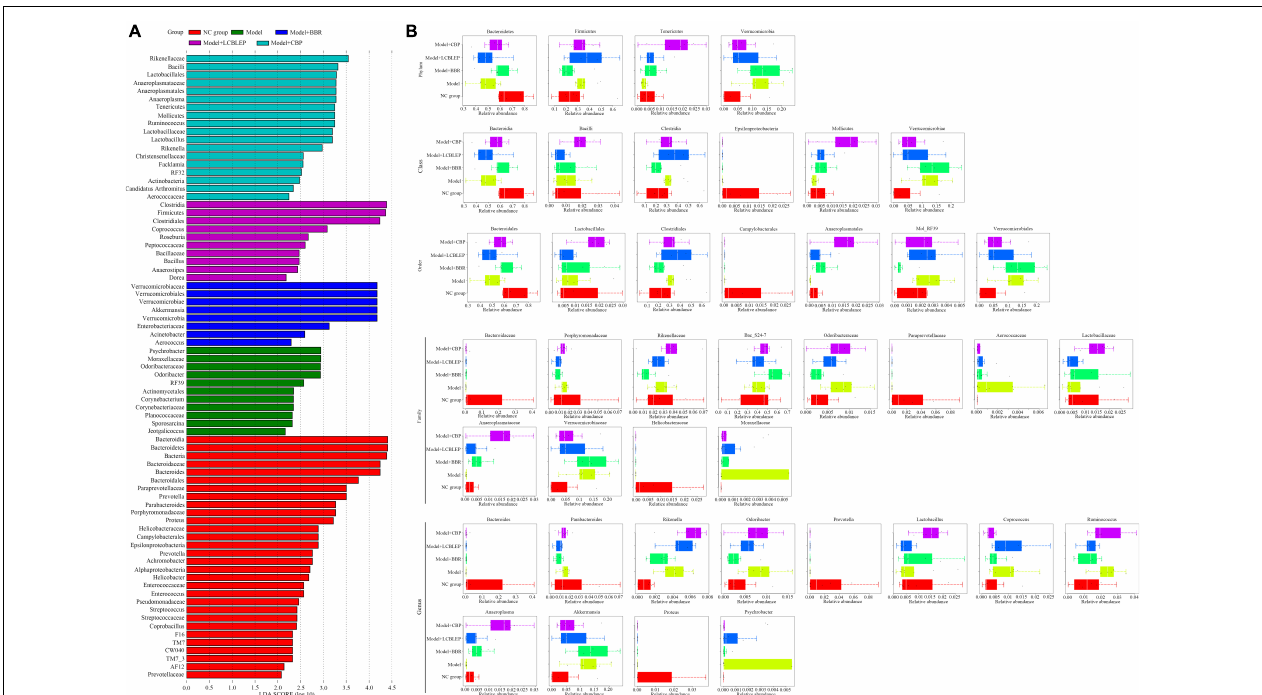
FIGURE 3 | (A) Species biomarkers were selected for comparison between groups through LEfSe analysis. (B) Box diagram of species with significant differences between groups at phylum, class, order, family, and genus level. The different colors in the figure represented the species with significant differences between groups.